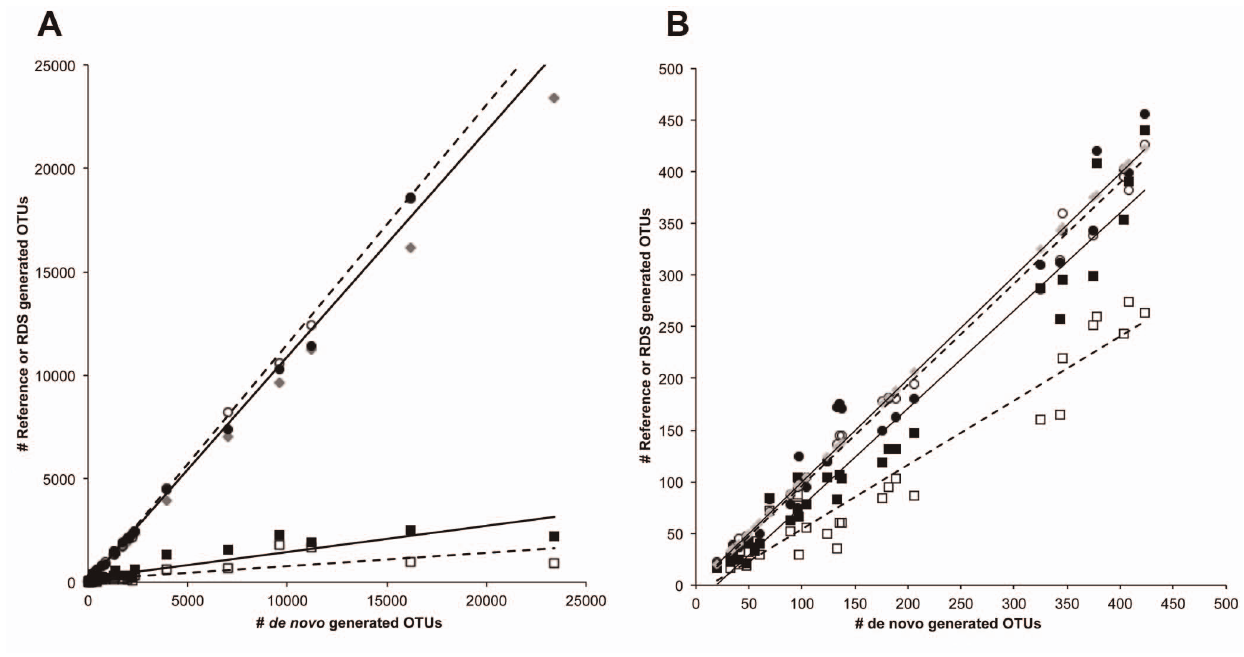
Figure 2. The RDS processing method replicates denovo OTU clustering better than reference-based clustering. The correlation between OTU clustering methods is shown by plotting the number of raw (a) and filtered (b) OTUs observed when using de novo OTU clustering versus reference or the RDS method. The reference-based OTU clustering results are depicted with squares while the RDS OTU clustering results are depicted with circles. Open markers indicate samples where the Greengenes 2012 reference was used while closed markers indicate samples where the Greengenes 2013 reference was used. De novo results are depicted as gray diamonds. Linear regression lines are shown for the reference and RDS datasets, with dash lines fitted to datasets processed using the Greengenes 2012–10 reference and solid lines fitted to datasets processed using the Greengenes 2013–08 reference.